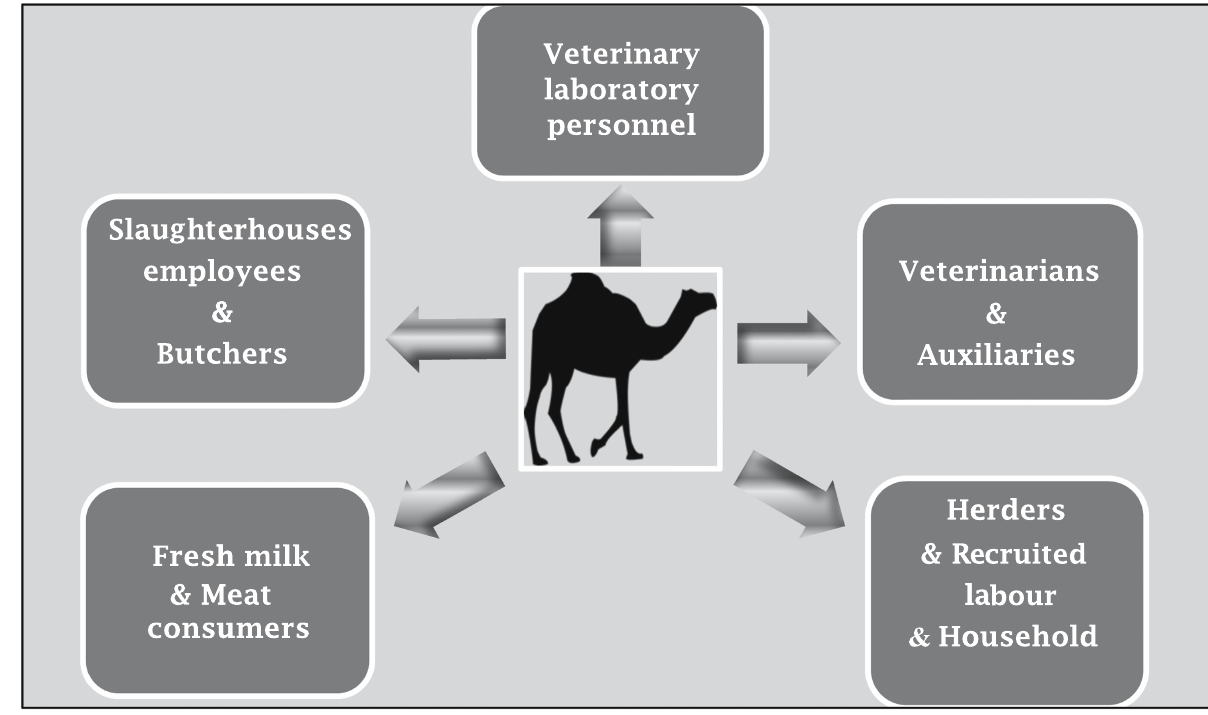
Figure 3: Socioprofessional and consumers ’ categories at risk to contract camelids ’ brucellosis ( Mammeri )